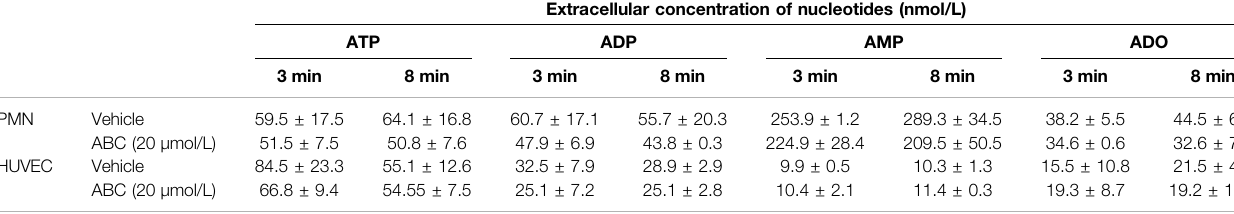
Extracellular concentration of nucleotides